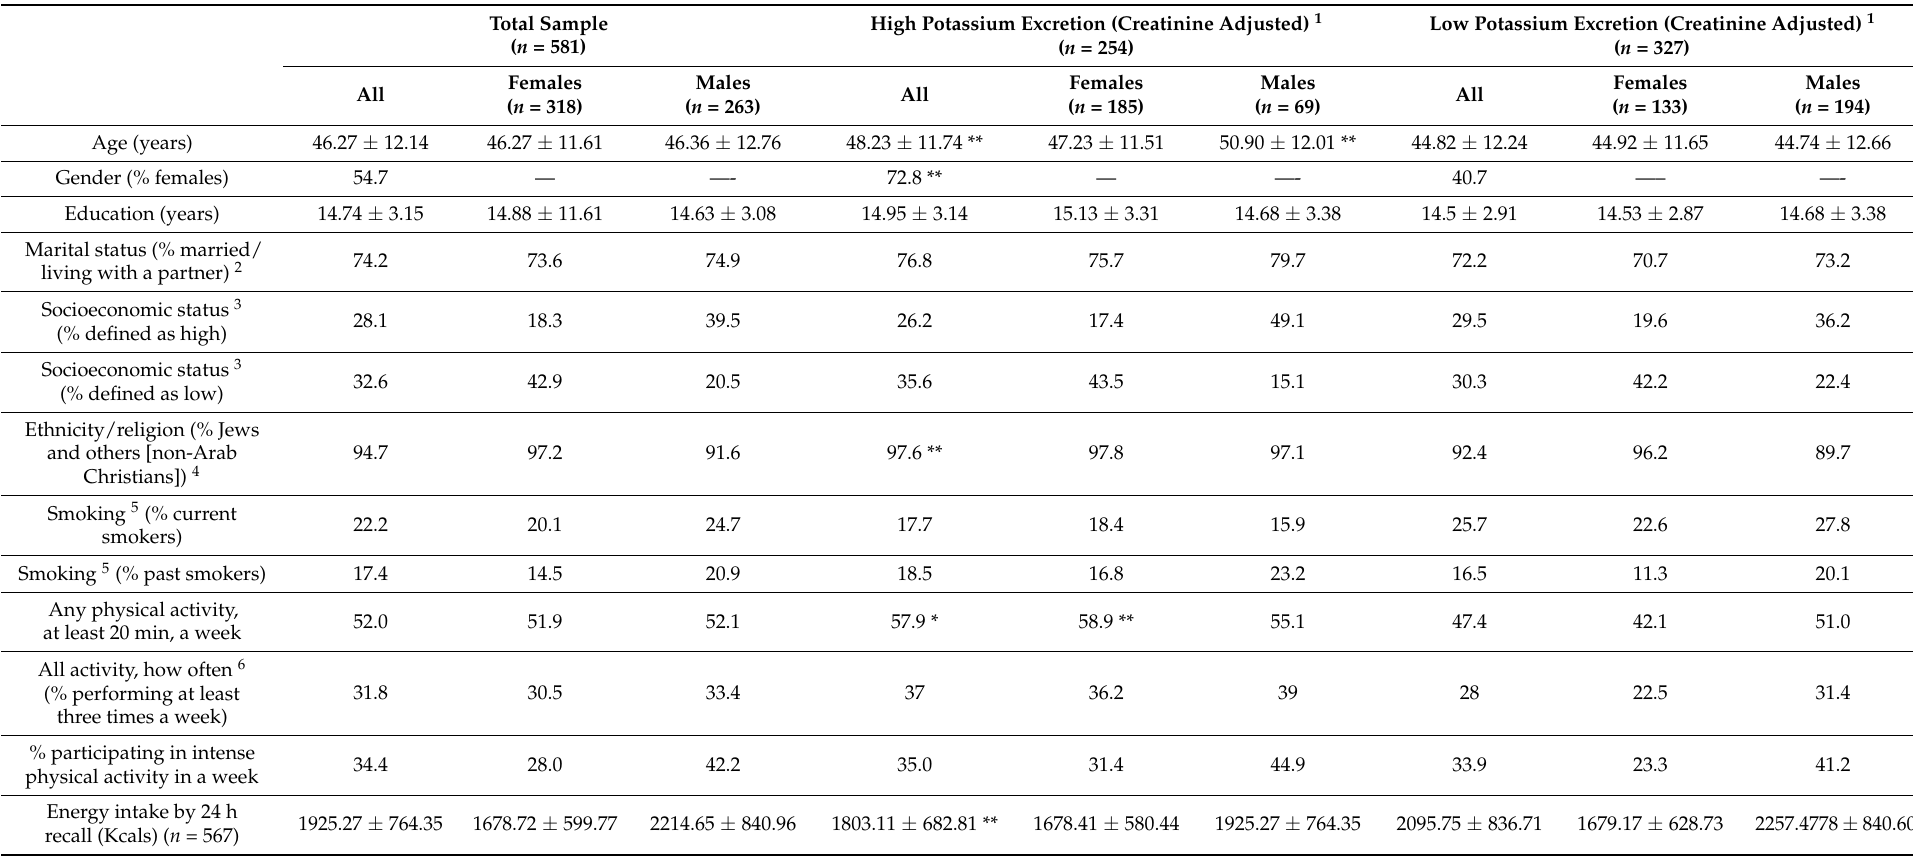
Table 1. Participants’ general and lifestyle characteristics with stratification to potassium excretion groups